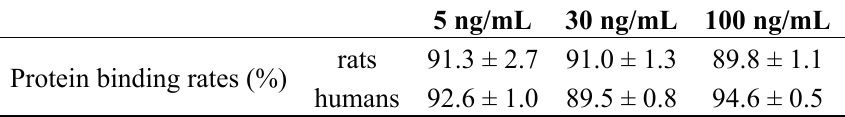
Table 3. The protein binding rates (%) of verticinone in the plasma of rats and humans in vitro (Mean ± S.D., n = 4).